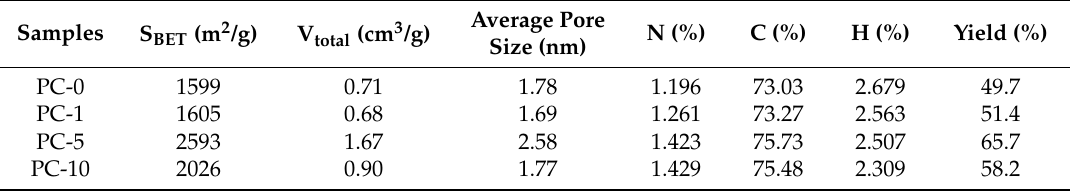
Table 1. The specific surface area, pore structures, elemental analysis, and carbon yield of porous carbon. Average Samples S BET (m 2 /g) V total (cm 3 /g)